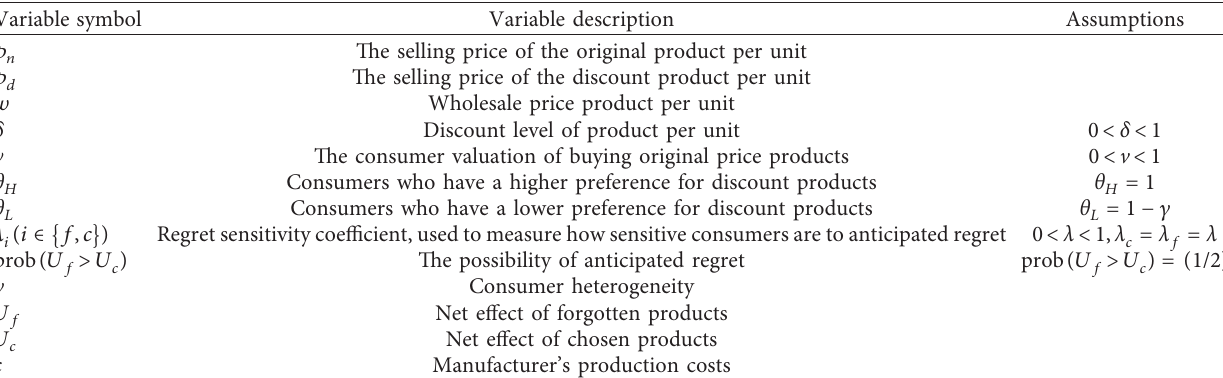
Table 2: Explanation of major symbols and